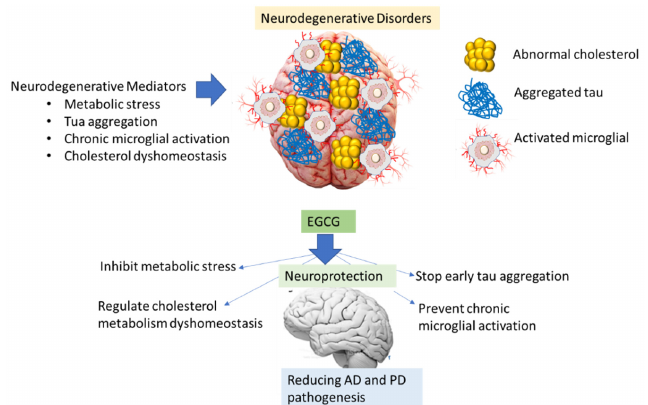
Figure 6. Picture Summary of EGCG highlights of this paper . Picture summary of key medicinal actions of EGCG as discussed in this review article.